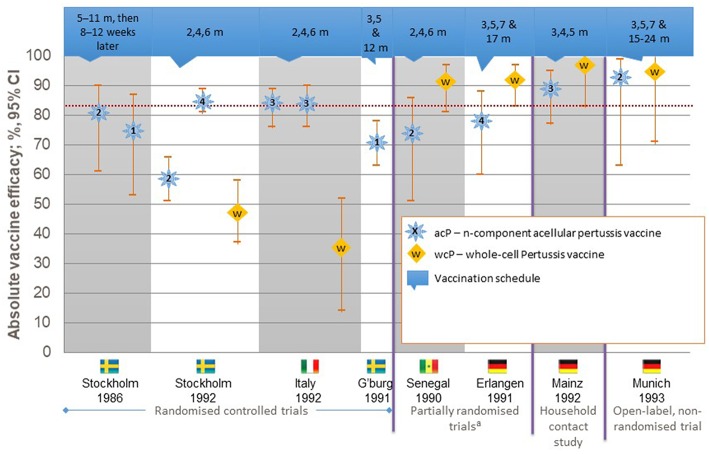
Efficacy of pertussis vaccines against World Health Organization-defined typical pertussis.